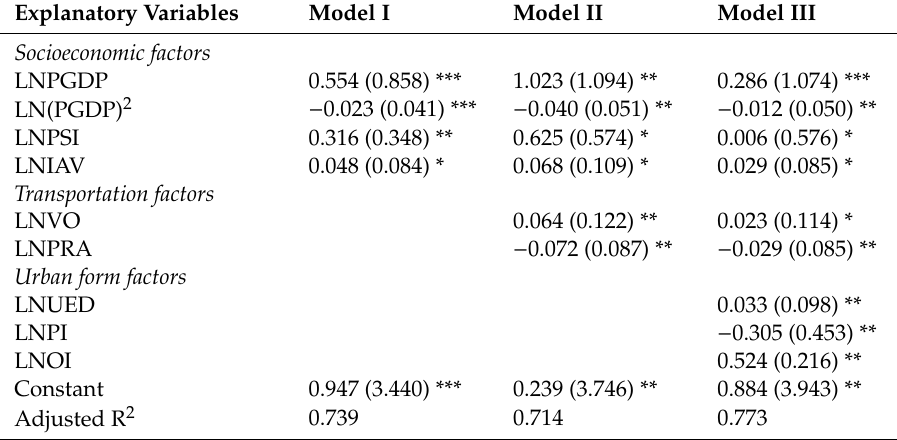
Table 2. Multivariate relationship of socioeconomic, transportation and urban form metrics with the near-surface PM2.5 concentrations calculated by the improved stochastic impacts by regression on population, a ffl uence, and technology (STIRPAT) model. The standard deviation is shown in parentheses. PGDP refers to per capita GDP; PSI refers to the proportion of the second industry; IAV refers to industrial added values; VO refers to vehicle ownership; PRA refers to per capita road area; UED refers to the density of a given urban extent; OI refers to openness index; PI refers to proximity index. * p -value < 0.1, ** p -value < 0.05, *** p -value <